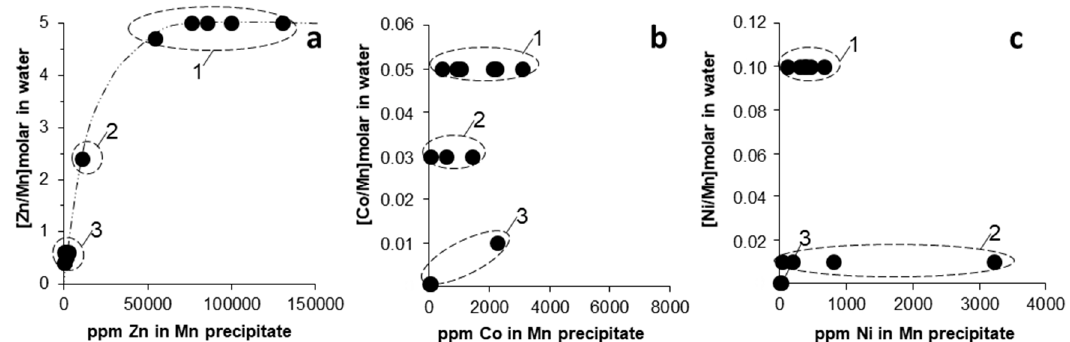
Figure 6. Binary plots showing the relation between trace metal content (( a ) Zn, ( b ) Co, ( c ) Ni) in Mn oxides, and the corresponding molar ratio of trace metal-to-Mn in the parent solutions (Table 1) (( a ) [Zn/Mn] molar , ( b ) [Co/Mn] molar , ( c ) [Ni/Mn] molar ). The encircled areas represent the different Mn oxide types (1–3; legend as in Figure 5).